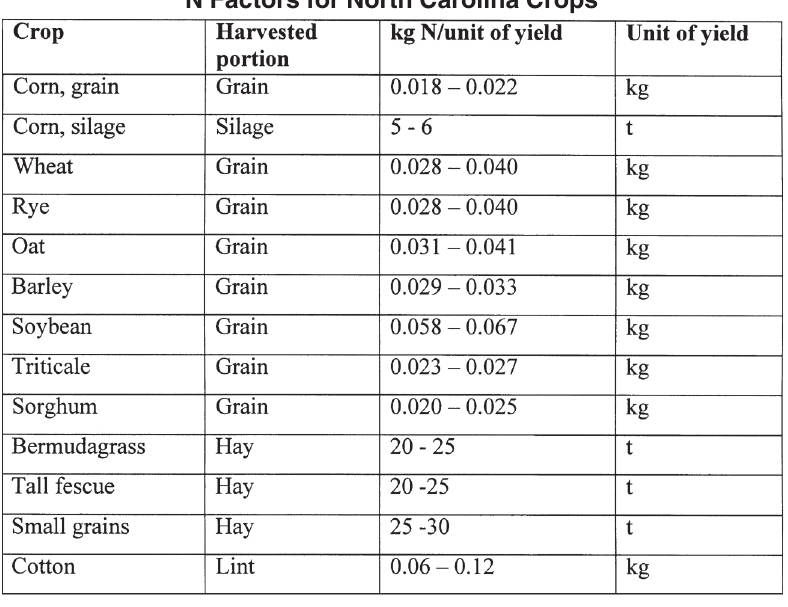
N Factors for North Carolina Crops